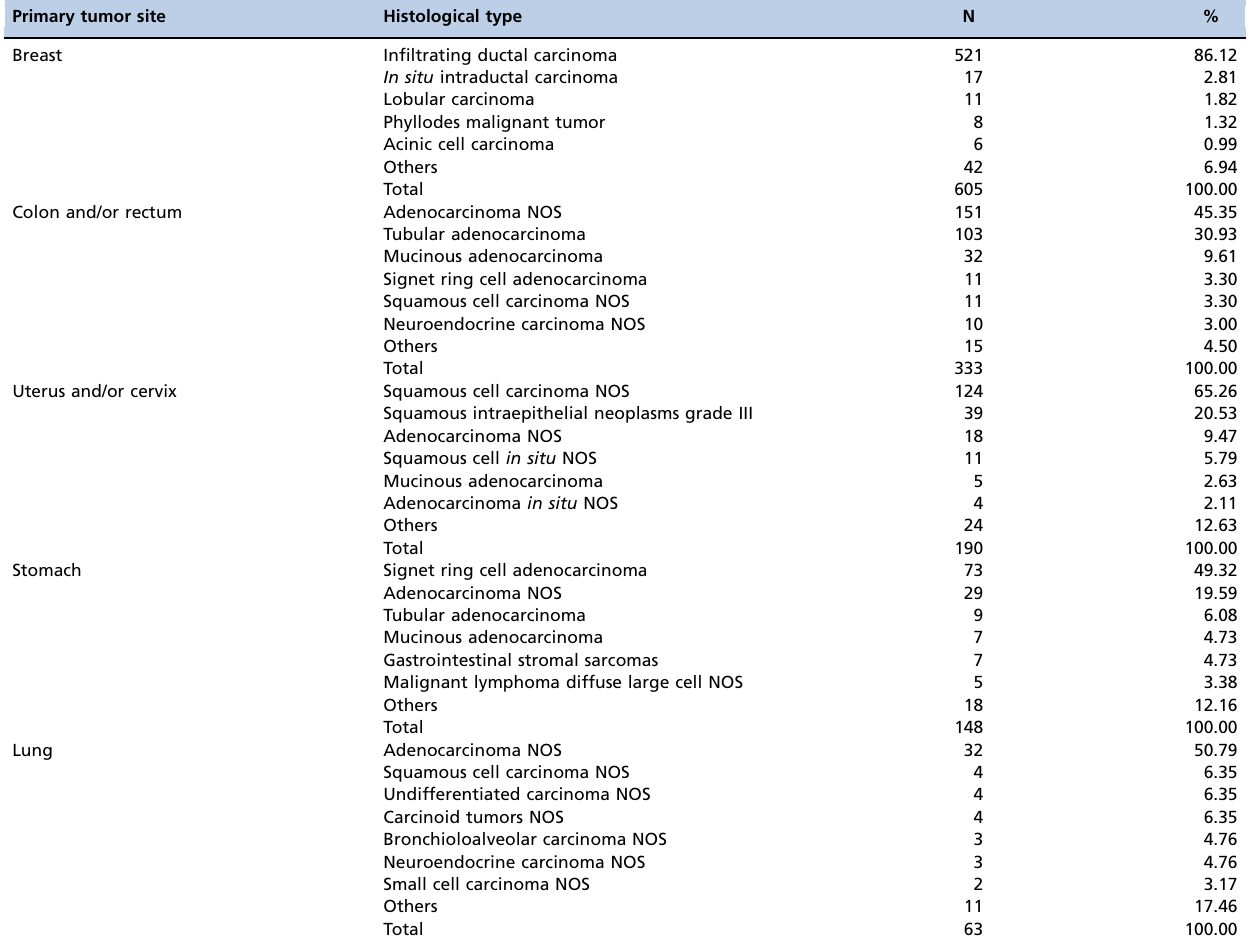
Table 2 - Tumor histological types in young adults. Primary tumor site